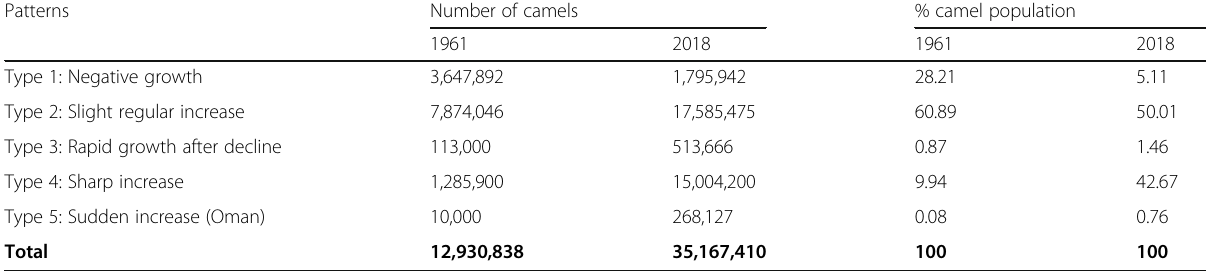
Table 2 Distribution (number of camel heads and percentage of the world camel population) Patterns Number of